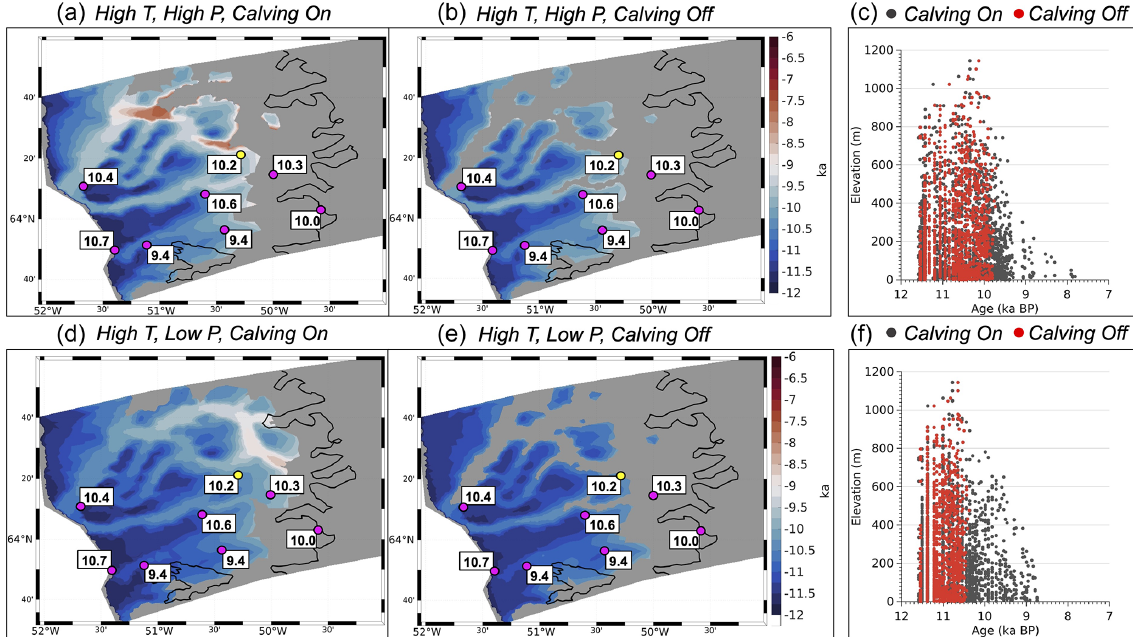
Figure 5. Map of simulated deglaciation ages for high-temperature scenarios with (a) high precipitation and calving on, (b) high precipitation and calving off, (d) low precipitation and calving on, and (e) low precipitation and calving off. Gray mask is the simulated ice extent at present day, and the black line denotes the actual present-day ice extent (Rignot and Mouginot, 2012). Magenta circles are the best estimate of the timing of deglaciation at that point based on 10 Be surface exposure ages in thousands of years, and the yellow dot shows minimum limiting radiocarbon age (Young et al., 2021). Scatter plot of simulated deglaciation age (above sea level) versus bedrock elevation for (c) high temperature and high precipitation and (f) high temperature and low precipitation. Red dots are from simulations without calving, and black dots are for simulations with